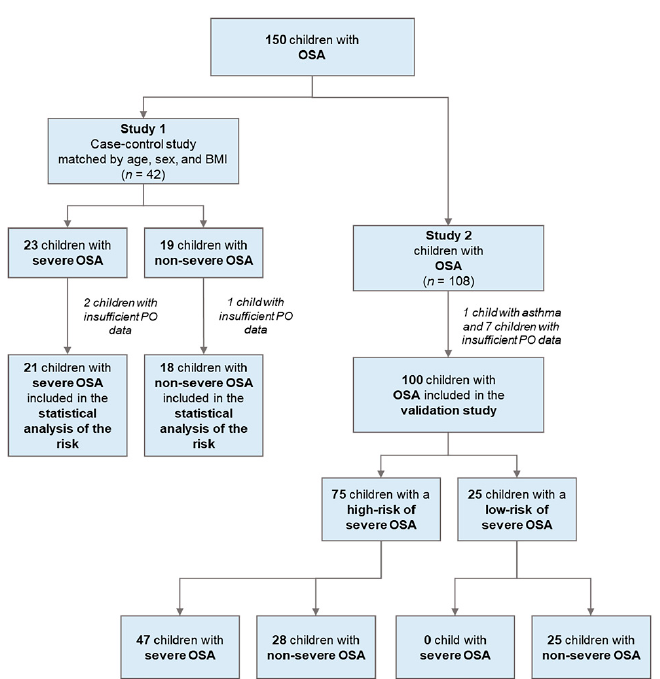
Figure 1. Case diagram. We included 150 eligible children with obstructive sleep apnea (OSA) for reviewing and excluded 11 patients from statistical analysis due to insufficient pulse oximetry (PO) data or a history of asthma. Twenty-one children with habitual snoring and severe OSA and 18 age-, sex-, and body mass index (BMI)-matched control children with habitual snoring and non- severe OSA comprised the final Study 1. One hundred additional children with OSA formed the final Study 2. Abbreviation: n : number. 3.1.2. Difference in Patients Characteristics of Study 1 In Study 1, the median AHI was 13.8 events/h (IQR: 3.2–25.3), including 21 (54%) with severe OSA and 18 (46%) with non-severe OSA. The characteristics of these two sub- groups categorized by OSA severity are shown in Table 1. The severe OSA subgroup had a significantly larger tonsil size (effect size = 1; 95% confidence interval (CI): 0–1), higher ANR (effect size = 0.12; 95% CI: 0.06–0.19), higher obstructive AHI (effect size = 19.0; 95% CI: 13.8–27.8), ODI3 (effect size = 18.9; 95% CI: 14.1–25.7), and SI (effect size = 160.0; 95% CI: 56.0–295.0), compared to the non-severe OSA subgroup. There were no significant dif- ferences in age, sex, BMI z-score, OSA-18, and obstructive AI.